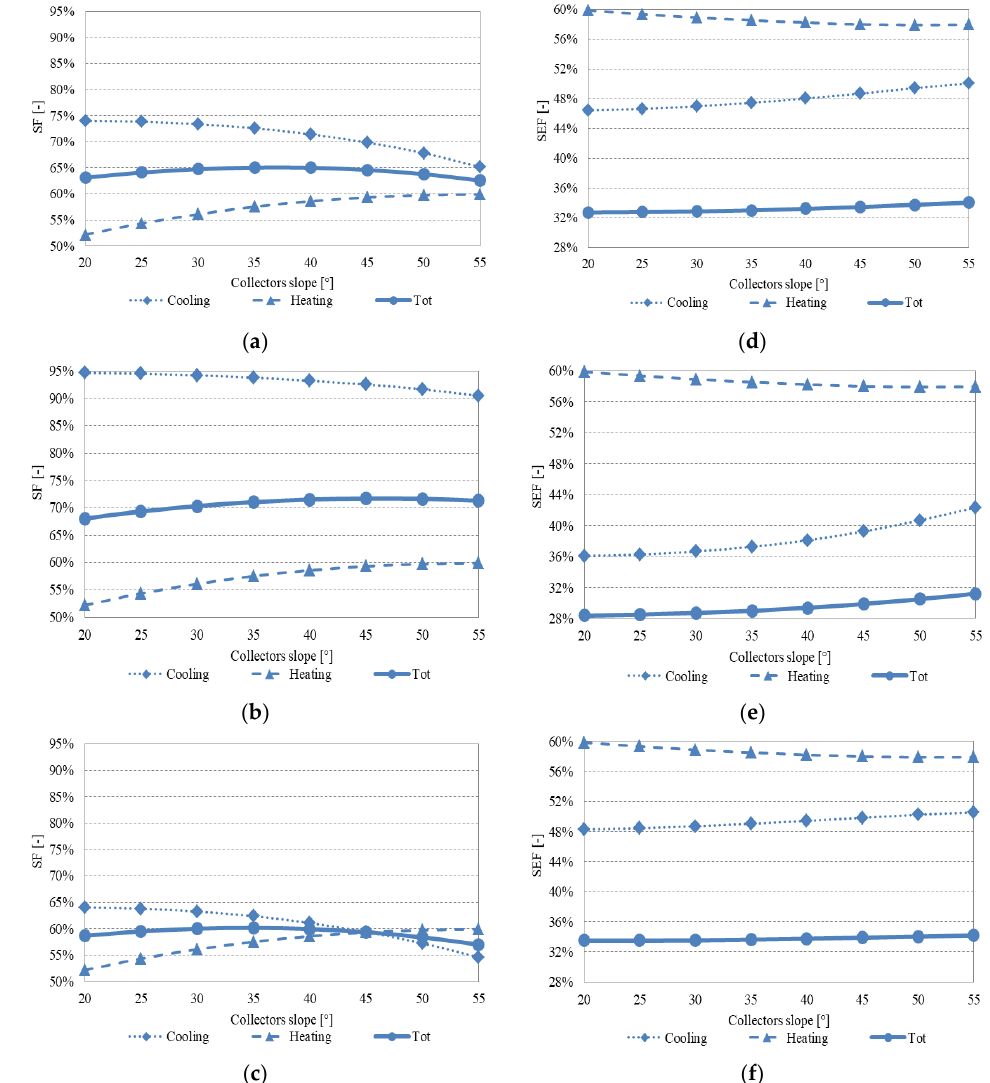
Figure 4. Solar fraction (left side) and solar energy factor (right side) as a function of the tilt angle in cooling operation, heating operation and total, for the plant with 20 m 2 of solar collectors and the innovative AHU equipped with: ( a , d ) silica-gel DW, ( b , e ) MILGO DW and ( c , f ) zeolite-rich tuff DW.